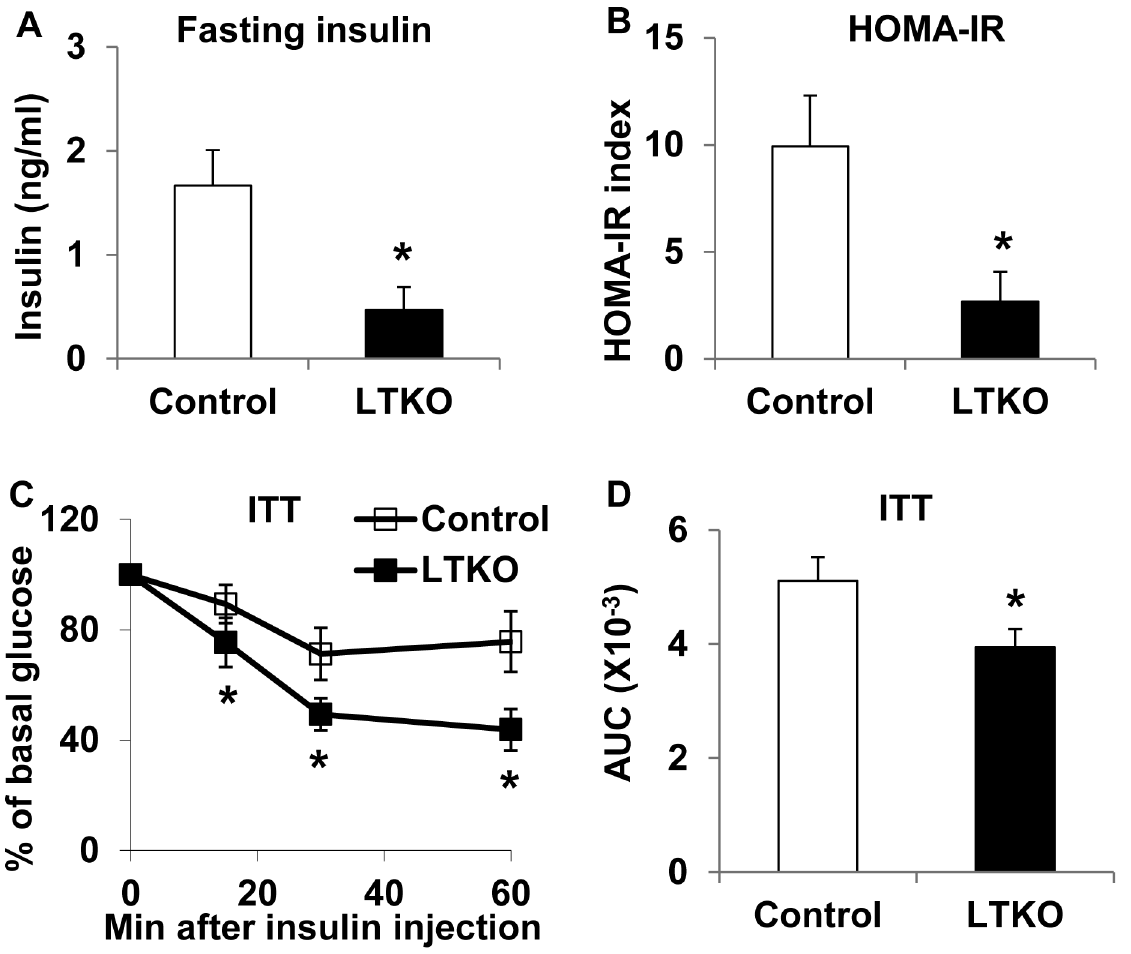
Figure 5. LTKO mice remain insulin-sensitive on a high-fat diet. (A) Fasting plasma insulin levels in 6-month male control and LTKO mice (n=8) after the treatment with a high-fat diet for 5 months. (B) HOMA insulin resistance (IR) index was calculated using the fasting blood glucose and insulin data collected from control and LTKO male mice treated with the high-fat diet for 5 months. (C, D) Insulin tolerance tests and the AUC analysis in 4-month male control and LTKO mice (n=8) using a dose of 1 U insulin per kg body weight after the treatment with the high-fat diet for 3 months, respectively. Data represent mean ± SEM. * indicates a significance with P <0.05 in control vs. LTKO